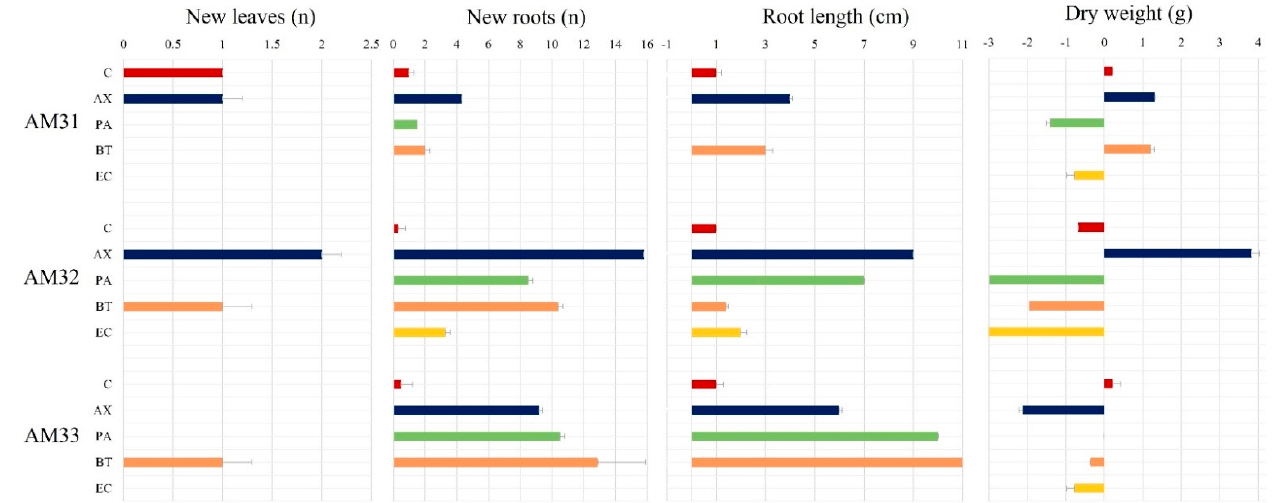
Figure 5. Endophytic bacteria affect the growth of clonal lines AM31, AM32 and AM33 under nutrient limitation. The plant control group was treated with a saline—glucose solution. The positive and negative effects on plant growth must be attributed directly to bacterial inoculation. Data are presented as the mean and standard error of the mean of inoculated plants in forming new leaves, roots, root length and dry weight 30 d post-inoculation. Values and mean represent three replicated experiments. C = control, AX = A. xylosoxydans , PA = P. aeruginosa , BT = B. tequilensis and EC = E. cloacae.